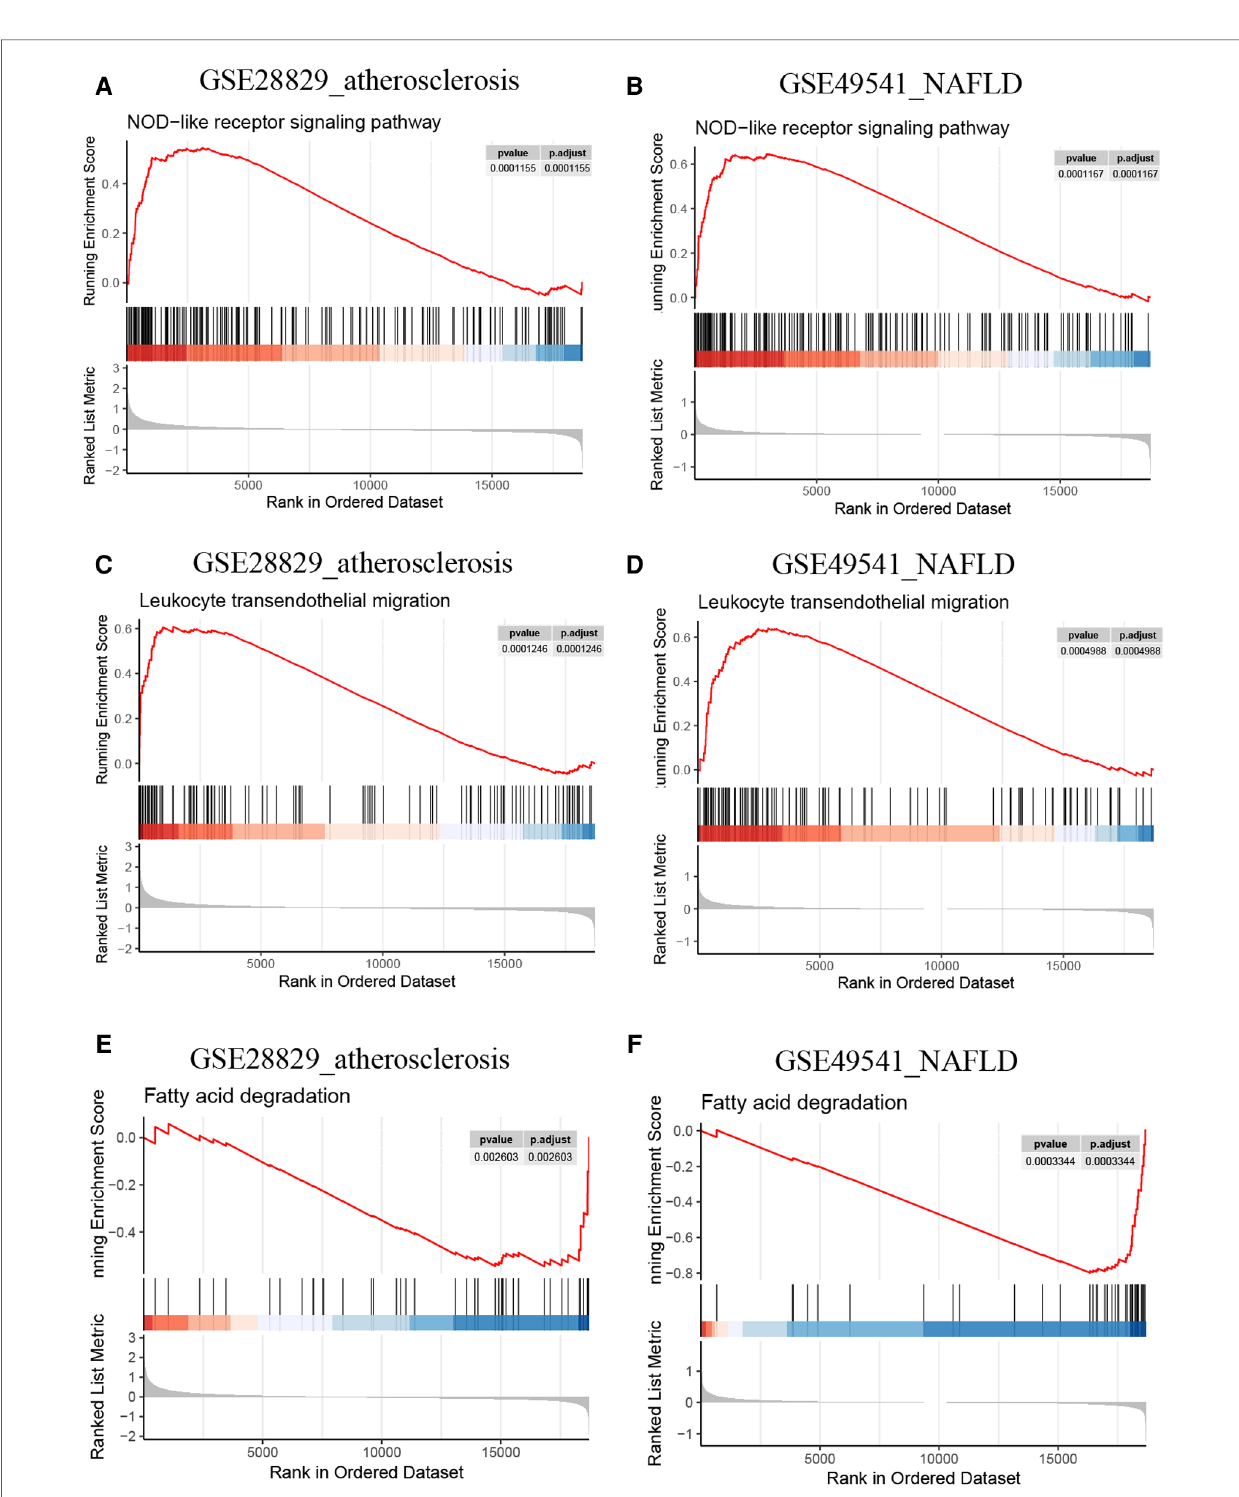
FIGURE 11 Single-gene GSEA of CCL19. ( A ) The NOD-like receptor signaling pathway from single-gene GSEA in GSE28829; ( B ) the NOD-like receptor signaling pathway from single-gene GSEA in GSE49541; ( C ) the leukocyte transendothelial migration from single-gene GSEA in GSE28829; ( D ) the leukocyte transendothelial migration from single-gene GSEA in GSE49541; ( E ) the fatty acid degradation from single-gene GSEA in GSE28829; ( F ) the fatty acid degradation from single-gene GSEA in